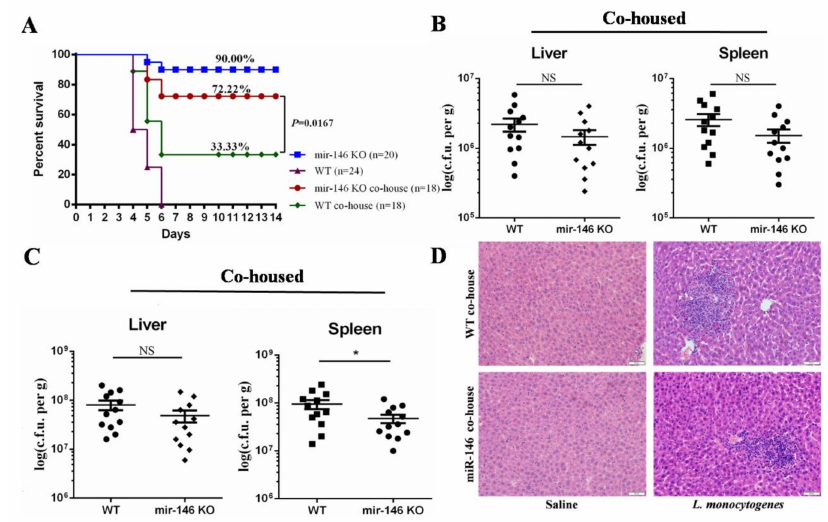
Figure 5. MiR-146a deficiency protects against L. monocytogenes infection by regulating the gut microbiota. ( A ) miR-146a KO co-housed with WT (miR-146a co-house) and WT co-housed with miR-146a KO mice (WT co-house) were infected i.p. with L. monocytogenes and survival was monitored daily for 14days; ( B ) bacterial loads in the liver and spleen on day1 ( n = 12); ( C ) bacterial loads in the liver and spleen on day3 ( n = 12); ( D ) liver sections from L. monocytogenes -infected mice